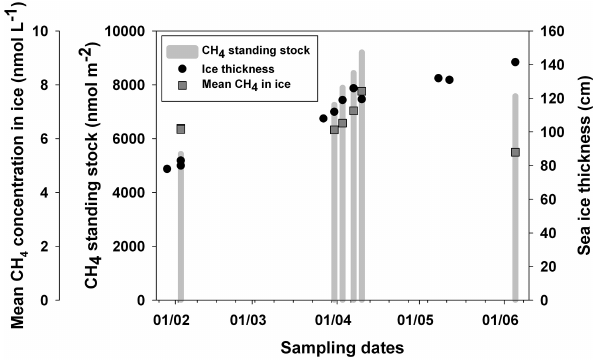
Figure 2. CH 4 standing stock for selected samplings events (verti- cal bars, from left to right, BRW2, BRW4, BRW5, BRW6, BRW7 and BRW10) in parallel with mean CH 4 concentration in sea ice and sea ice